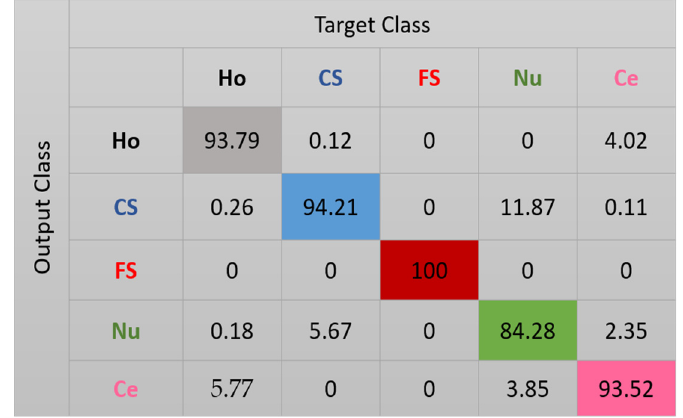
Figure 9. Confusion matrix for case-2. “Ho”, “CS”, “FS”, “Nu”, and “Ce” represent homogeneous, coarse speckled, fine speckled, nucleolar and centromere cells, respectively.